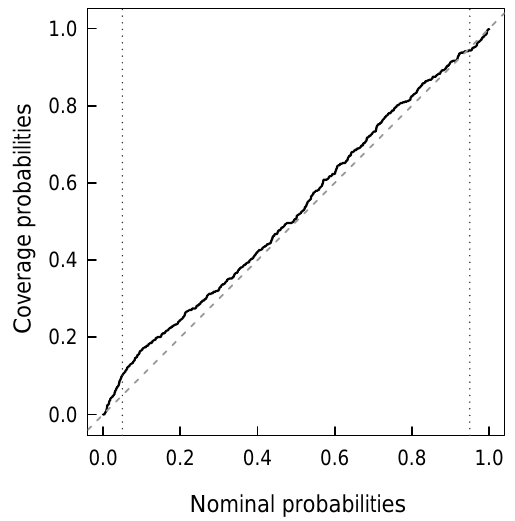
Figure 2. Change in cross-validation root mean square error (RMSE) in steps 1–5 of the model-building procedure (Sect. 2.2).